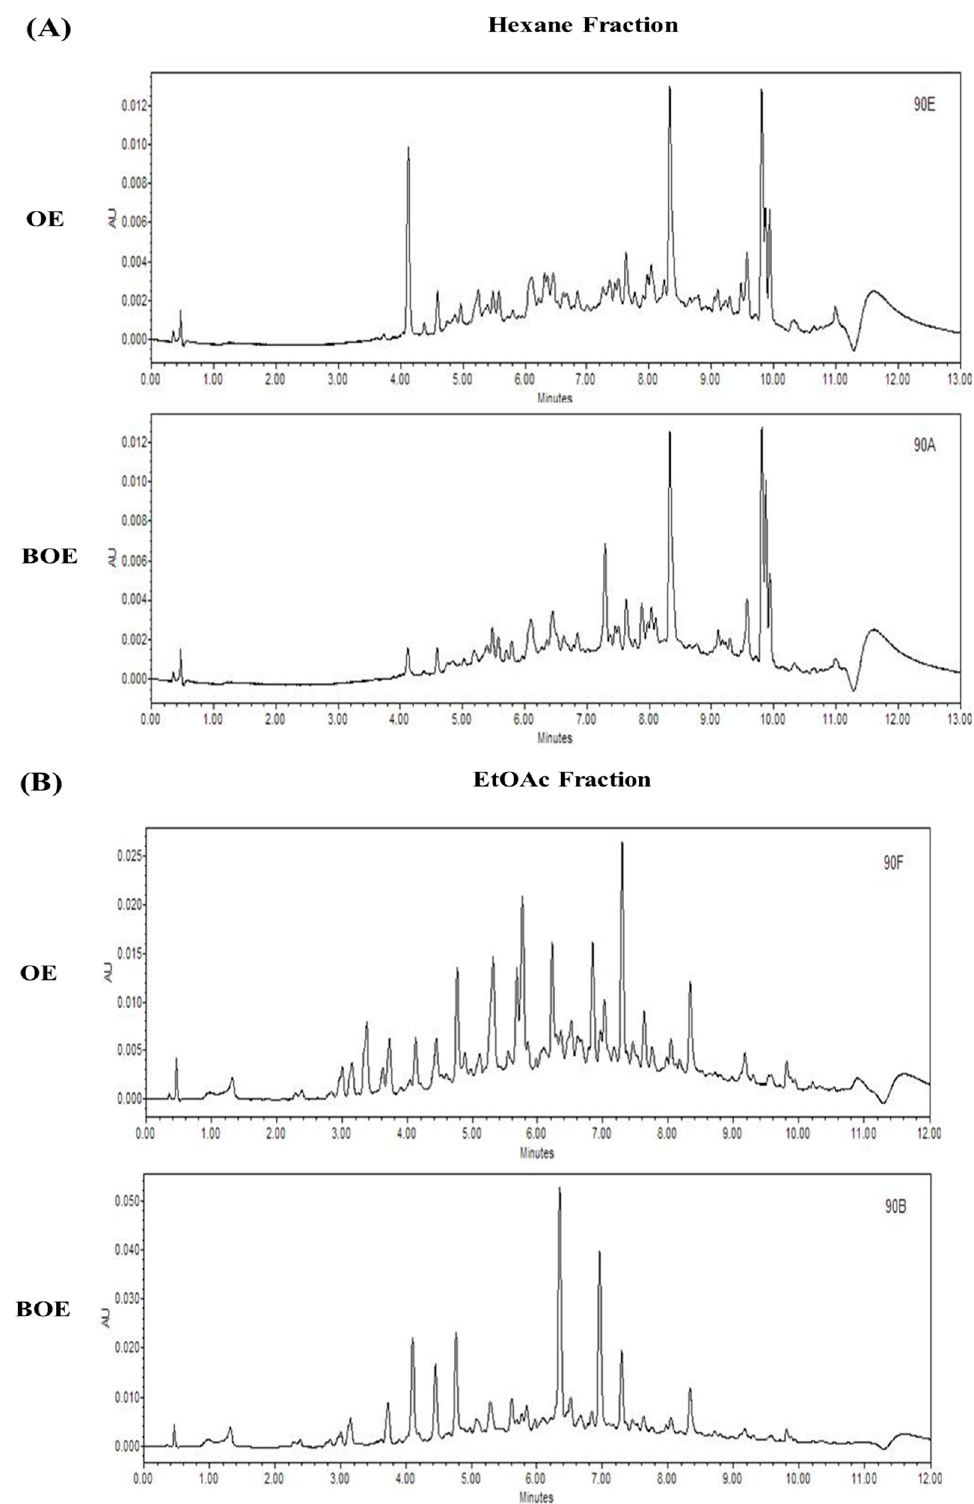
Figure 5. Figure 5. Cont .